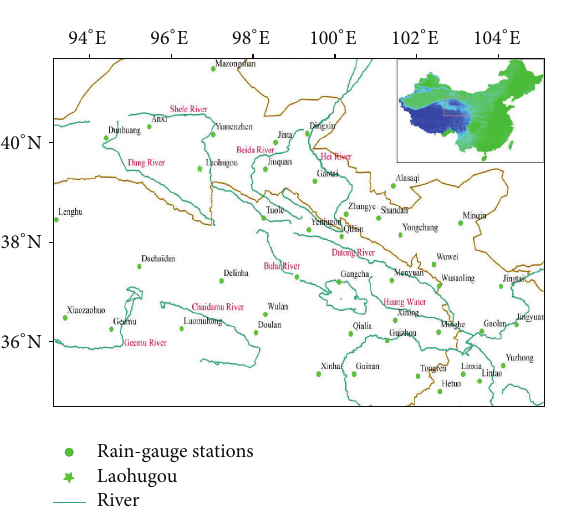
Figure 2: Location map showing the northeastern edge of the Tibetan Plateau and 44 observation stations.